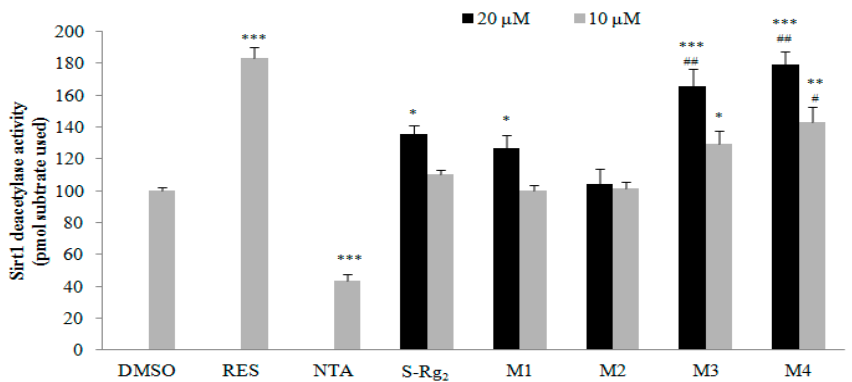
Figure 4. Effects of 20( S )-G-Rg 2 (S-Rg 2 ) and its metabolites M1 , M2 , M3 , M4 on SIRT1 activity. RES (resveratrol, 10 µM) was used as a positive activator and NTA (nicotiamide, 10 µM) was used as a positive inhibitor. For all assays, the tested compounds were dissolved in dimethyl sulfoxide (DMSO) and the final DMSO concentration was 0.1% ( v / v ). * p < 0.05, ** p < 0.01, *** p < 0.001 compared with DMSO (control) group in three separate experiments. # p < 0.05, ## p < 0.01 compared with S-Rg 2 group in three separate experiments.